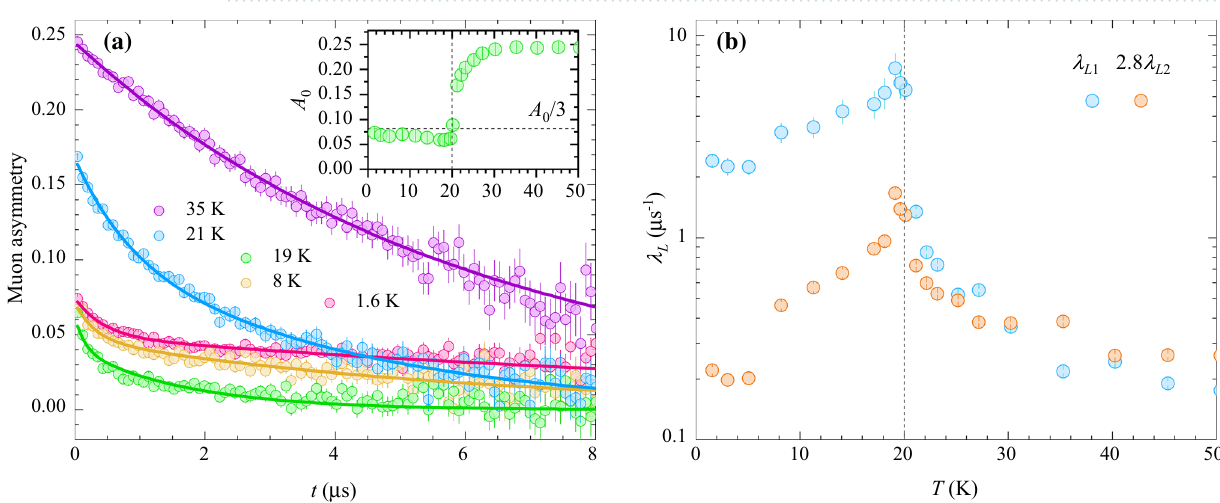
Figure 5. ( a ) Zero-field muon asymmetry in BMTO at short times above and below T N solid lines are fits with the model (4). ( b ) The temperature dependence of the internal fields at the two muon stopping sites. The solid lines demonstrate critical scaling of internal fields with critical exponent β text for details), which is further highlighted on a log–log scale in the inset. The vertical dashed line shows the position of T N .